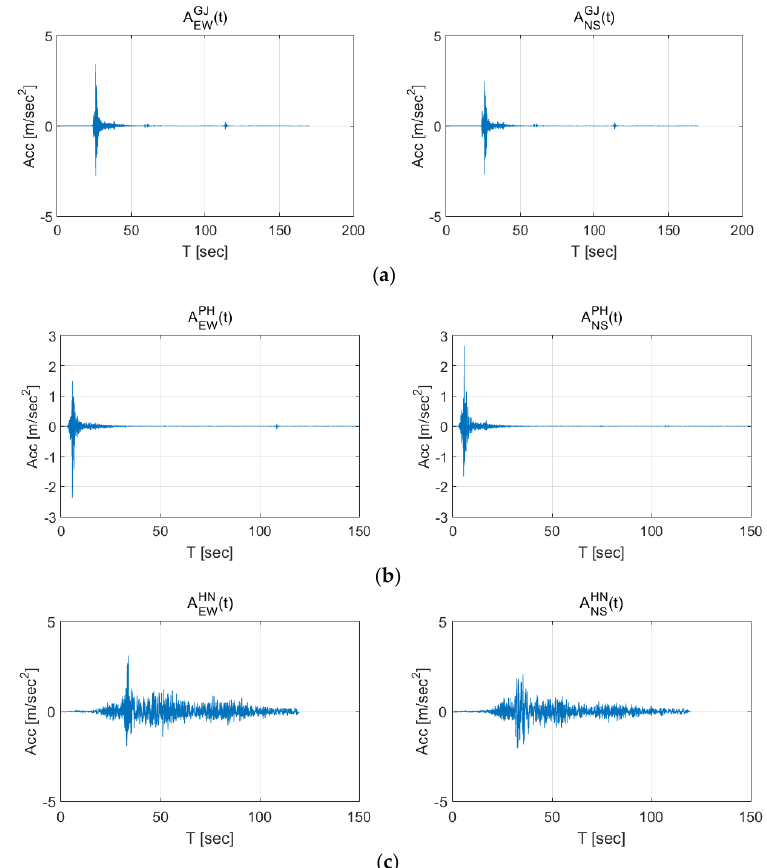
Figure 2. Seismic activities in ( b ) Gyeongju (2016), ( b ) Pohang (2017), and ( c ) Hachinohe (1994).